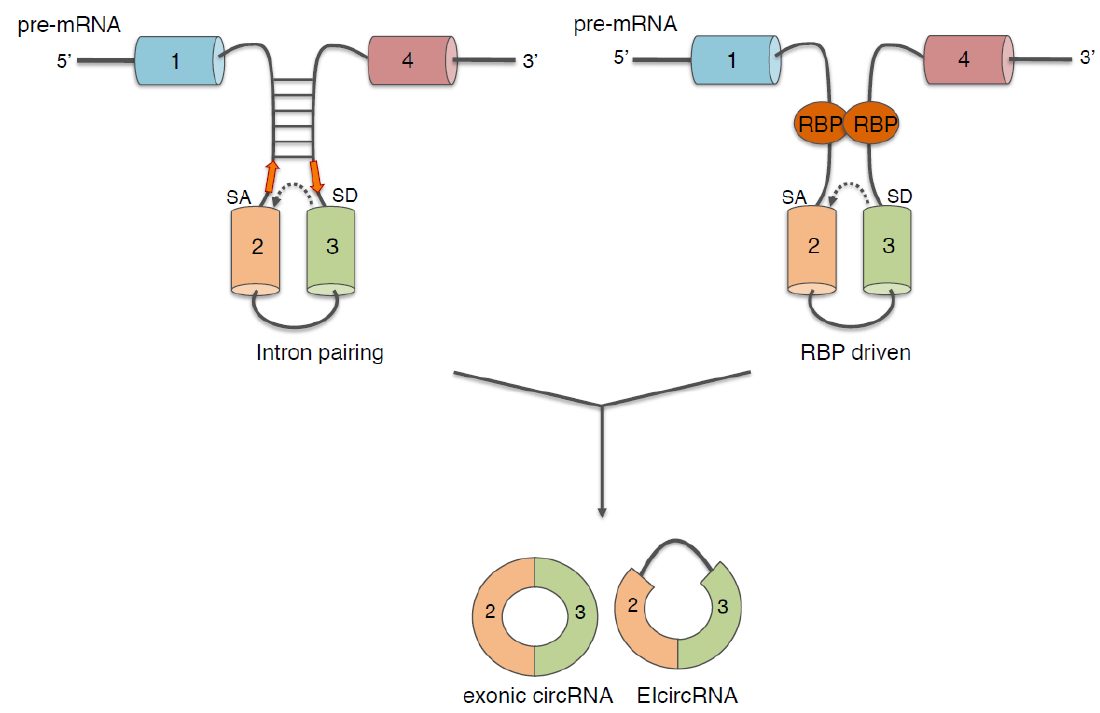
Figure 2. Features promoting circularization. Reverse complementary sequences (left; orange arrows indicate the reverse complementarity) and / or RNA-binding proteins (RBPs; right), act to bring the downstream splice-donor site (SD) into close proximity with an upstream splice-acceptor site (SA), thus, facilitating back- splicing reaction (dashed arrow).